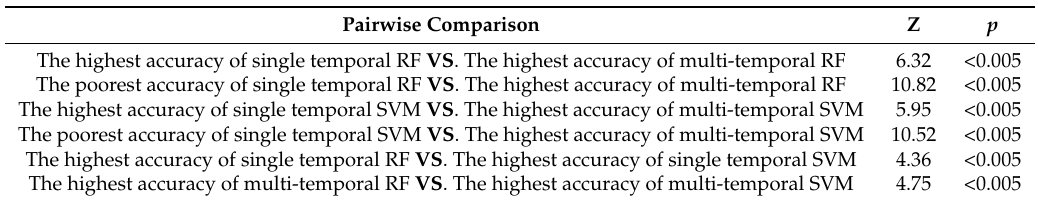
Table 8. Z-test values for the pairwise comparison of the error matrices of multi-temporal mapping. Pairwise Comparison Z